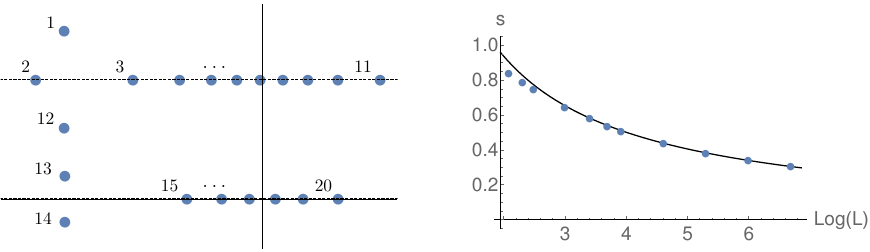
Figure 9. On the left panel, the pattern of Bethe roots for the winding state with S z = 0, w = +1 and L = 20. Data for s ( L ) computed from the solution to the BA equations for the corresponding RG trajectory is represented by the points in the graph on the right panel of the (cid:12)gure. The line is a plot of s ( L ) coming from the quantization condition (23) with m = 2. The parameters were taken to be (cid:13) = (cid:25) and k = 1 5 25